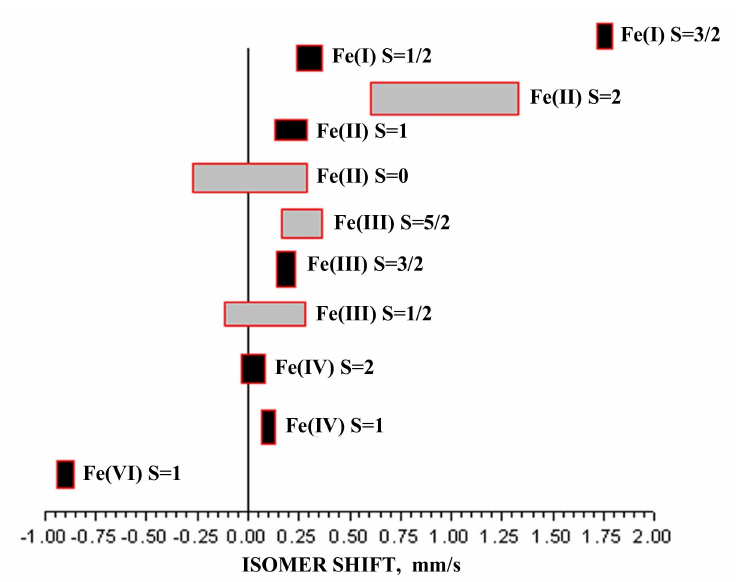
Figure A5. Relation of isomer shift and Fe valence/spin